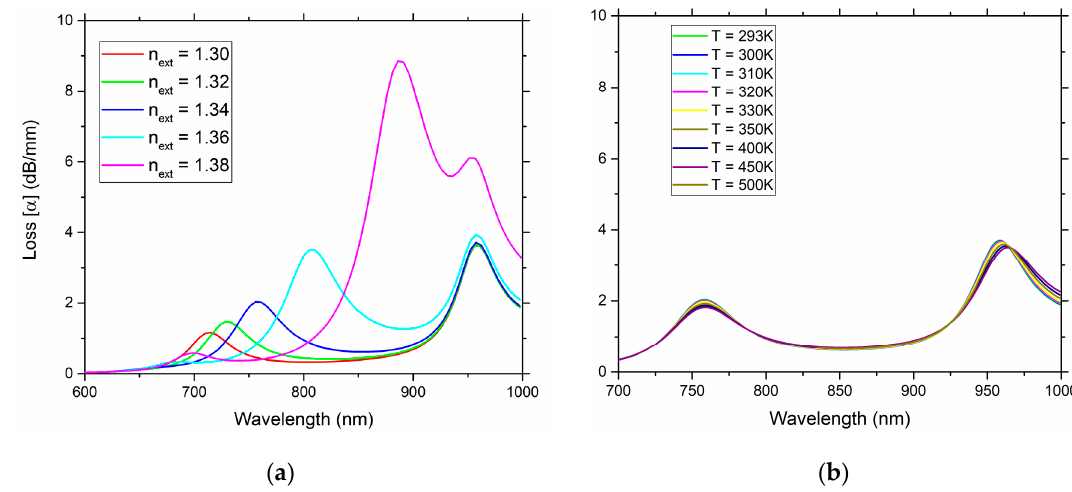
Figure 11. Loss versus wavelength of the sensor for: different external refractive index values, for a constant temperature of 293 K ( a ); different temperature values, with a constant external refractive index of 1.34 ( b ).